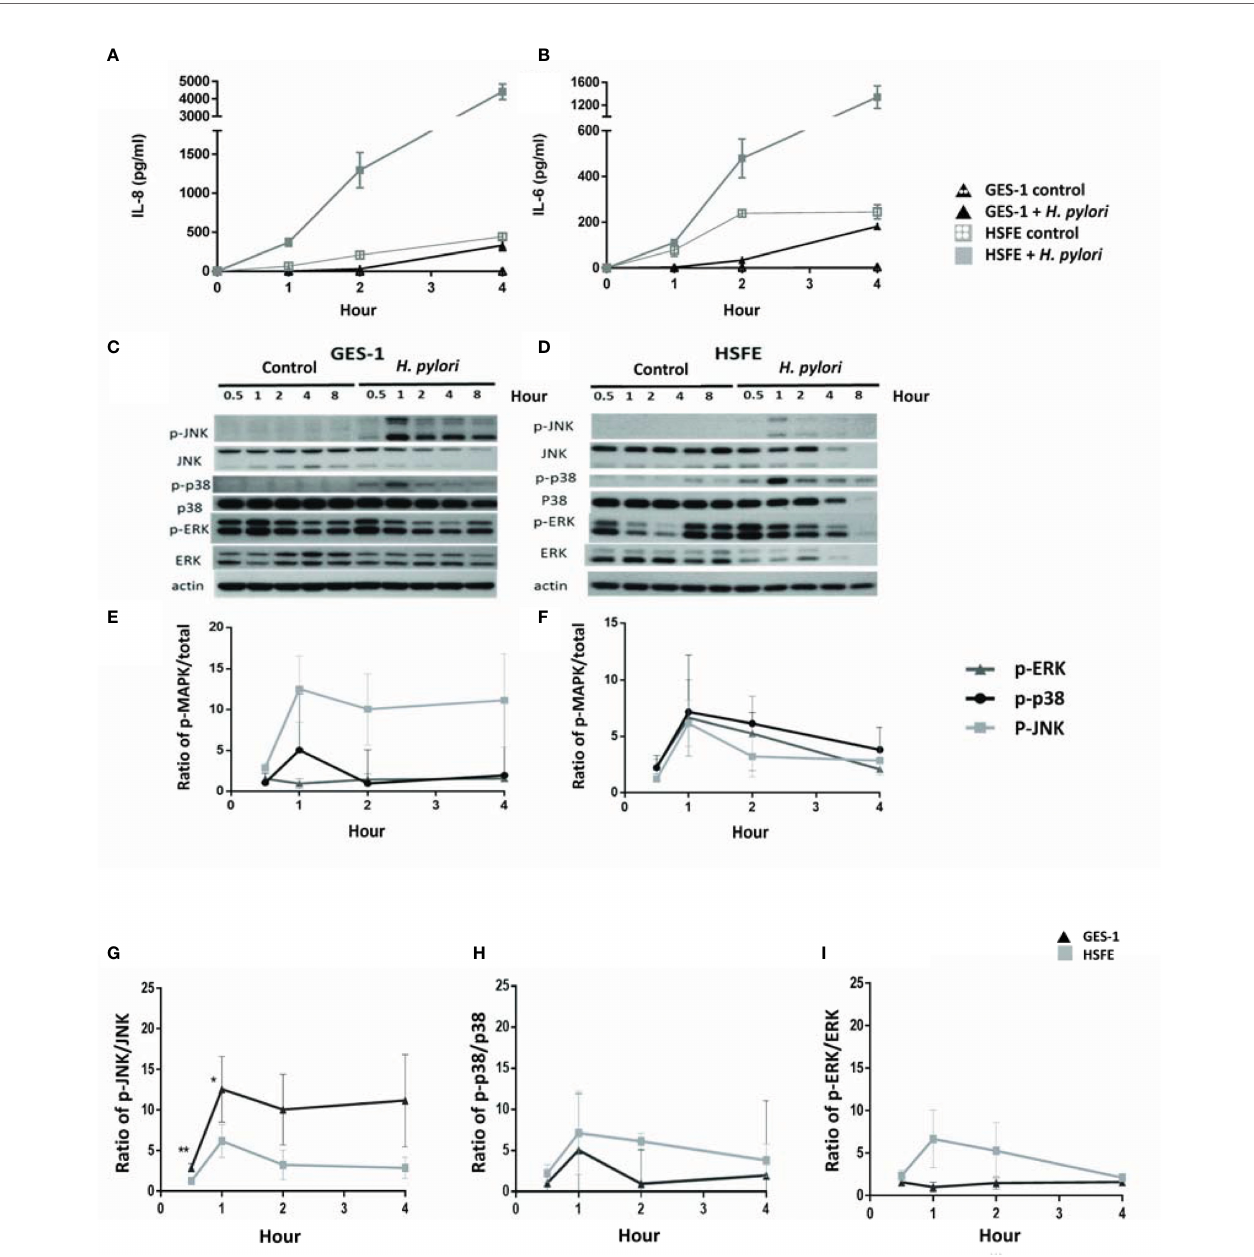
FIGURE 4 | Differences in H. pylori -induced cytokine expressions and phosphorylation of MAPK signaling between GES-1 and HSFE cells over time. GES-1 (black triangles) and HSFE (gray squares) cells were infected (solid) or not infected (hollow) with H. pylori (MOI 100) for 0, 0.5, 1, 2, and 4 hours. The levels of IL-8 (A) and IL-6 (B) were detected by ELISA. The phosphorylation of JNK, p-38, and ERK in GES-1 (C) and HSFE (D) cells after H. pylori challenging were measured by Western blot and were quantitated in (E, F) , respectively. For comparisons of the differential MAPK activation between GES-1 and HSFE cells after H. pylori infection, the ratios of (G) p-JNK/JNK, (H) p-p-38/p-38, and (I) p-ERK/ERK are shown between GES-1 and HSFE cells. (* P < 0.05, ** P <